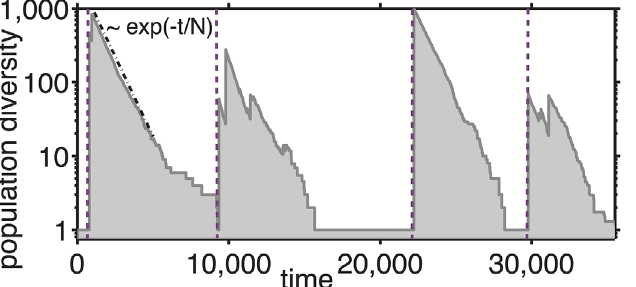
Fig 2. Diversity dynamics. The grey shaded area shows the the time course of the population diversity D ¼ P 1 = P 2 in our model with N = 1000 and γ = 10 − 12 . Purple dashed lines mark the beginnings of diversity waves i i when a collapse of the dominant species with P max ’ 1 leads to an abrupt increase in population diversity from * 1 to * N . The diversity subsequently decreases / exp( − t / N ) (dash-dotted line).